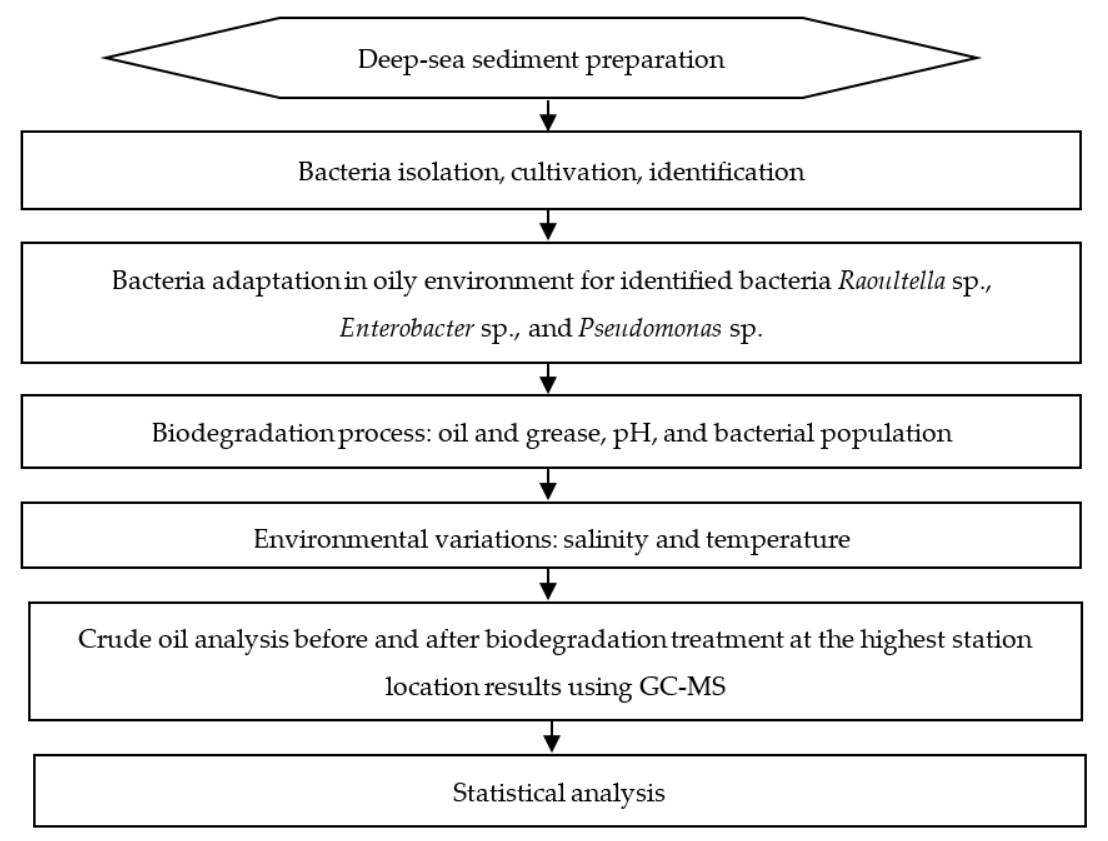
Figure 1. Schematic diagram of oil biodegradation research using deep-sea sediment bacteria.